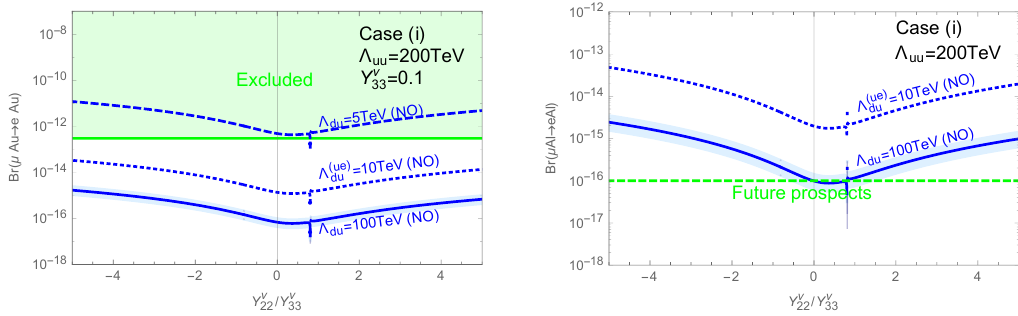
Figure 5 . The predictions of Br ( (cid:22) N ! e N ) ( N =Au (left), Al (right)). The thick and dashed blue lines depicts our predictions in the NO case with (cid:3) du = 100 TeV and 5 TeV, respectively. Y (cid:23) is (cid:12)xed at Y (cid:23) = 0 : 1 and M (cid:0) 1 = 0 is satis(cid:12)ed. (cid:3) ( ue ) uu and (cid:3) ( ue ) are (cid:12)xed at ((cid:3) ( ue ) uu ; (cid:3) ( ue ) ) = 33 33 (cid:23) 1 du du (100 TeV ; 100 (10) TeV) on the (dotted) lines. The green region is excluded by the experiment [77] and the dashed green line corresponds to the future prospect proposed in ref.